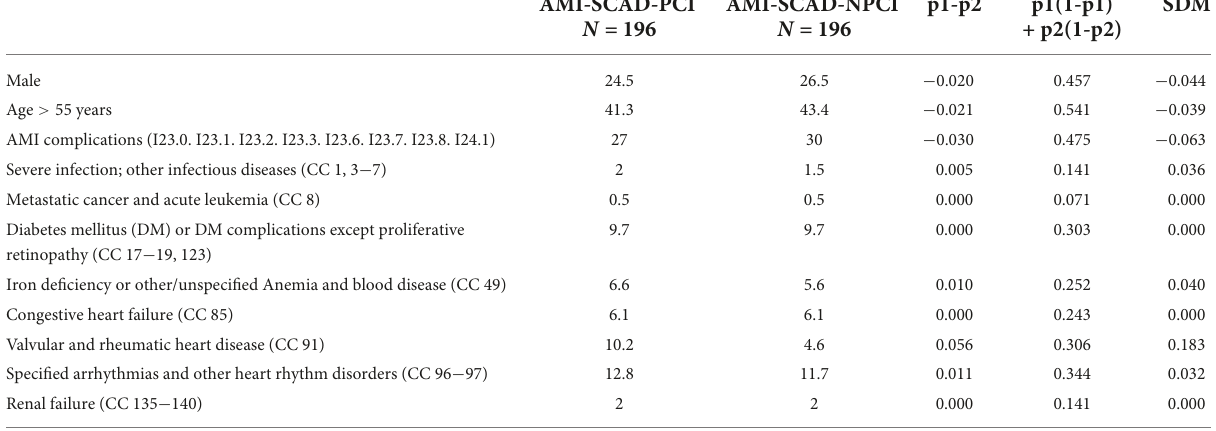
TABLE 4 Baseline characteristics of the matched